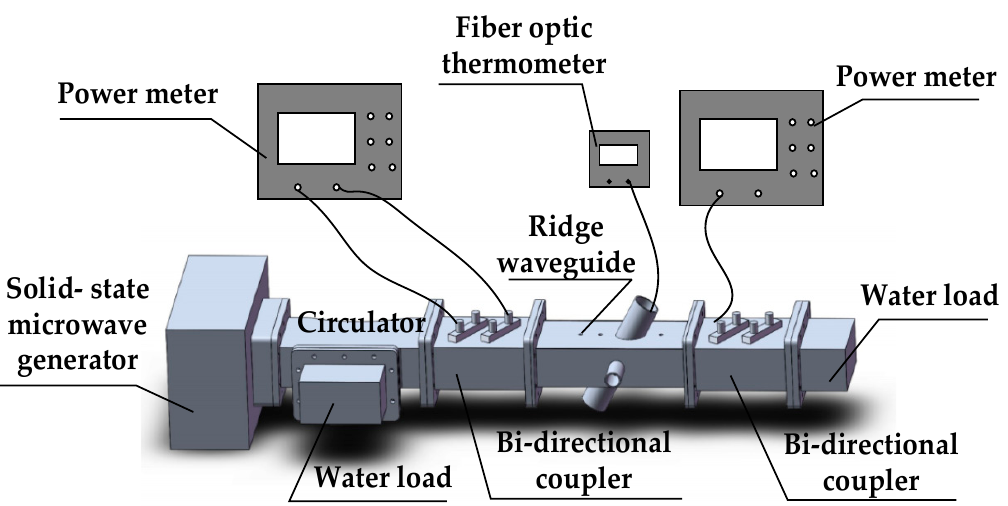
Figure 1. Permittivity measurement system at 2450 MHz. Figure 1. Permi tt ivity measurement system at 2450 MHz.